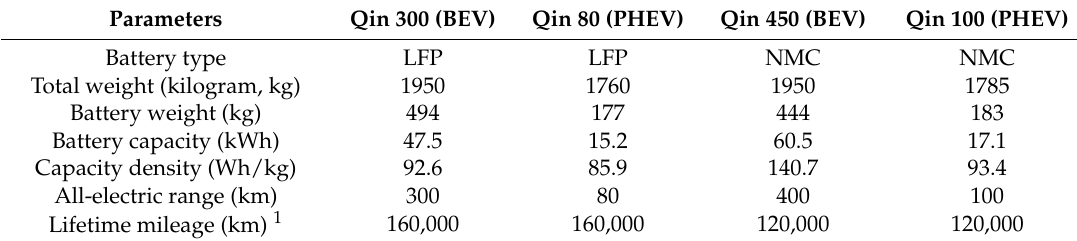
Table 2. The key parameters of representative